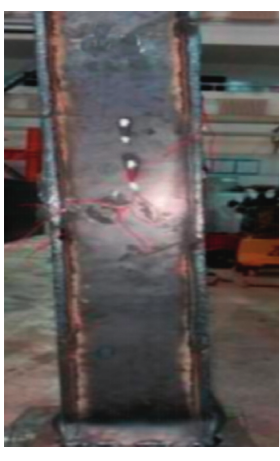
Figure 20: CF-1 failure